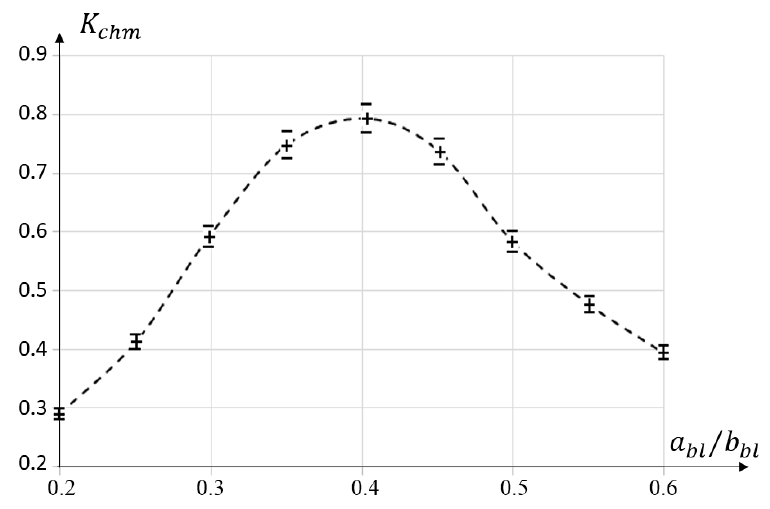
Figure 15. Homogeneity coe ffi cient of mixture K chm vs. parameter a bl / b bl (experimental Figure 15. Homogeneity coefficient of mixture 𝐾 (cid:3030)(cid:3035)(cid:3040) vs. parameter 𝑎 (cid:3029)(cid:3039) /𝑏 (cid:3029)(cid:3039) (experimental data). Figure 15. Homogeneity coefficient of mixture 𝐾 (cid:3030)(cid:3035)(cid:3040) vs. parameter 𝑎 (cid:3029)(cid:3039) /𝑏 (cid:3029)(cid:3039) (experimental data).